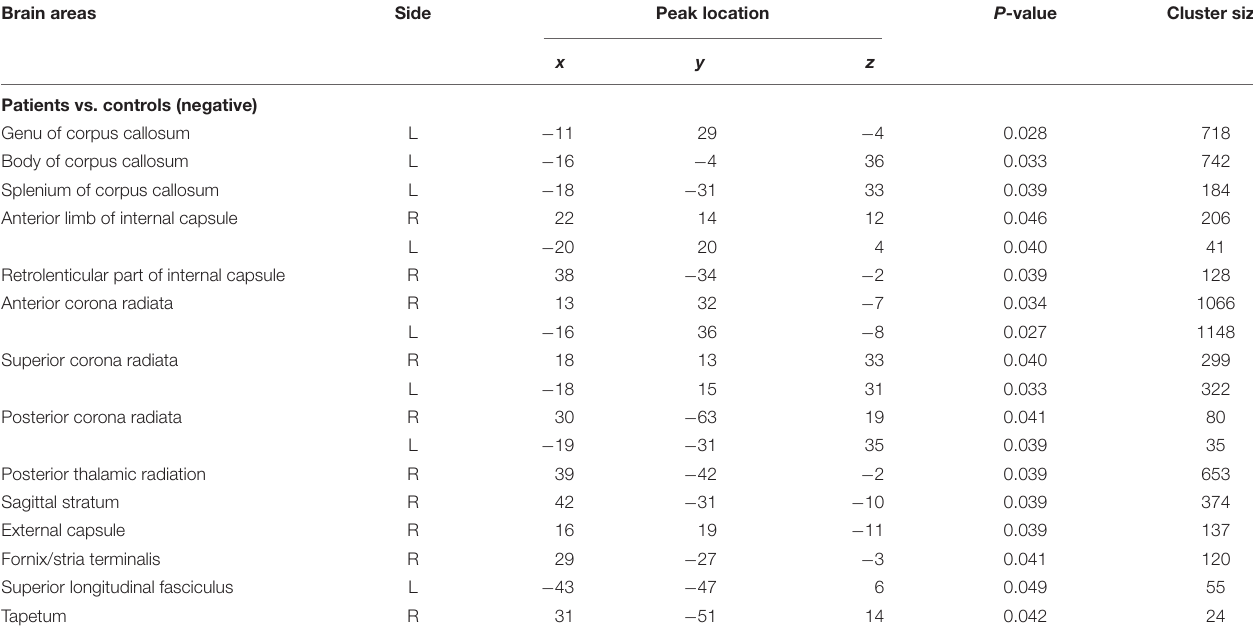
FIGURE 2 | Distribution map of the fractional anisotropy (FA) value that was significantly lower in the patients group compared with the control group based on the TBSS analysis (blue-lightblue). Statistical images ( p FWE < 0.05 corrected for multiple comparisons) were overlapped onto the mean of the skeleton (green) and the MNI152 template (gray-scale) for visualization. TBSS, tract-based spatial statistics; FST, fornix/stria terminalis; PTR, posterior thalamic radiation; SCR, superior corona radiate; ACR, anterior corona radiate; ALIC, anterior limb of internal capsule; GCC, genu of corpus callosum; SLF, superior longitudinal fasciculus; SS, sagittal stratum; PCR, posterior corona radiate; BCC, body of corpus callosum; EC, external capsule; SCC, splenium of corpus callosum; RLIC, retrolenticular part of internal capsule. TABLE 3 | Comparisons of FA maps between patients with anti-LGI1 encephalitis and normal controls. Brain